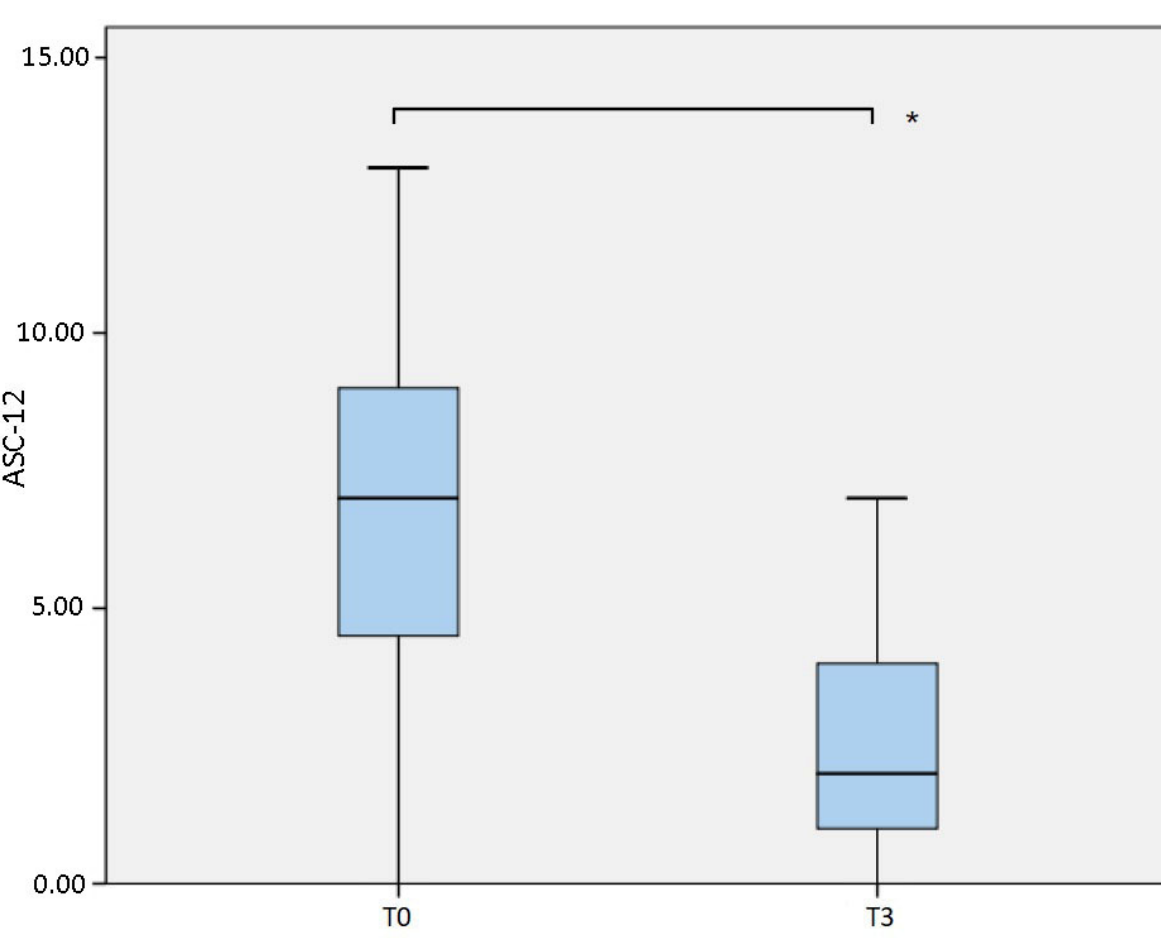
Figure 1. Comparison of Allodynia Symptoms Checklist 12 (ASC-12) measured at baseline (T0) and after 6 months (T3). * p = 0.001.